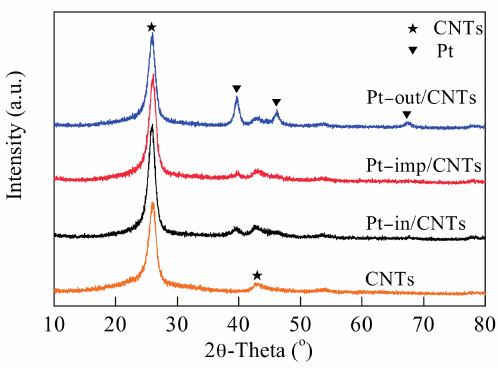
Figure 3. XRD patterns of CNTs, Pt–in/CNTs, Pt–imp/CNTs, and Pt–out/CNTs.